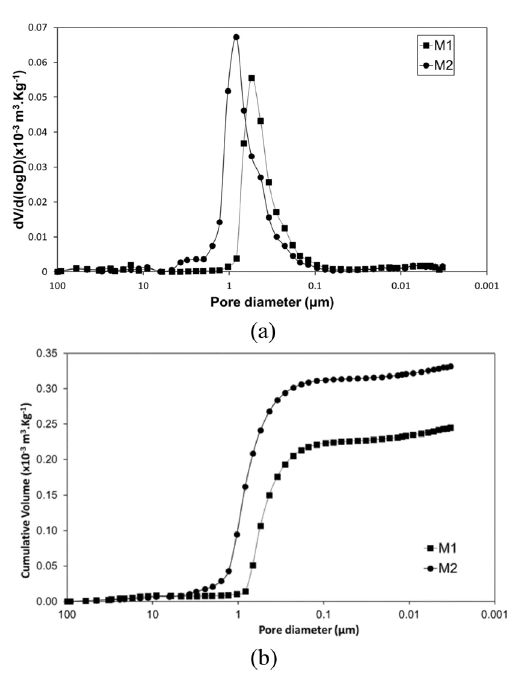
Figure 3. (a) pore size distribution and (b) cumulative volume for M1 and M2 membranes.